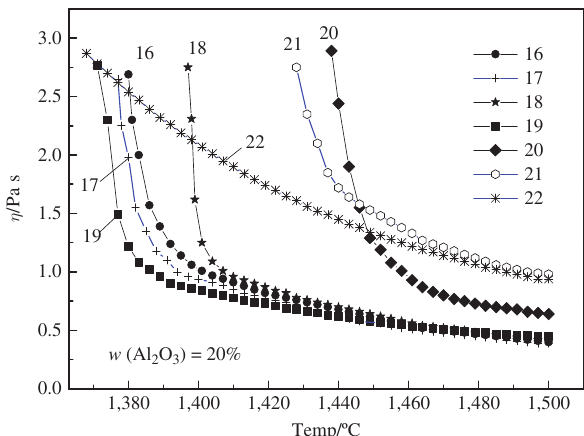
Figure 12: Effect of temperature on the viscosity of slag ( w (Al 2 O 3 ) ¼